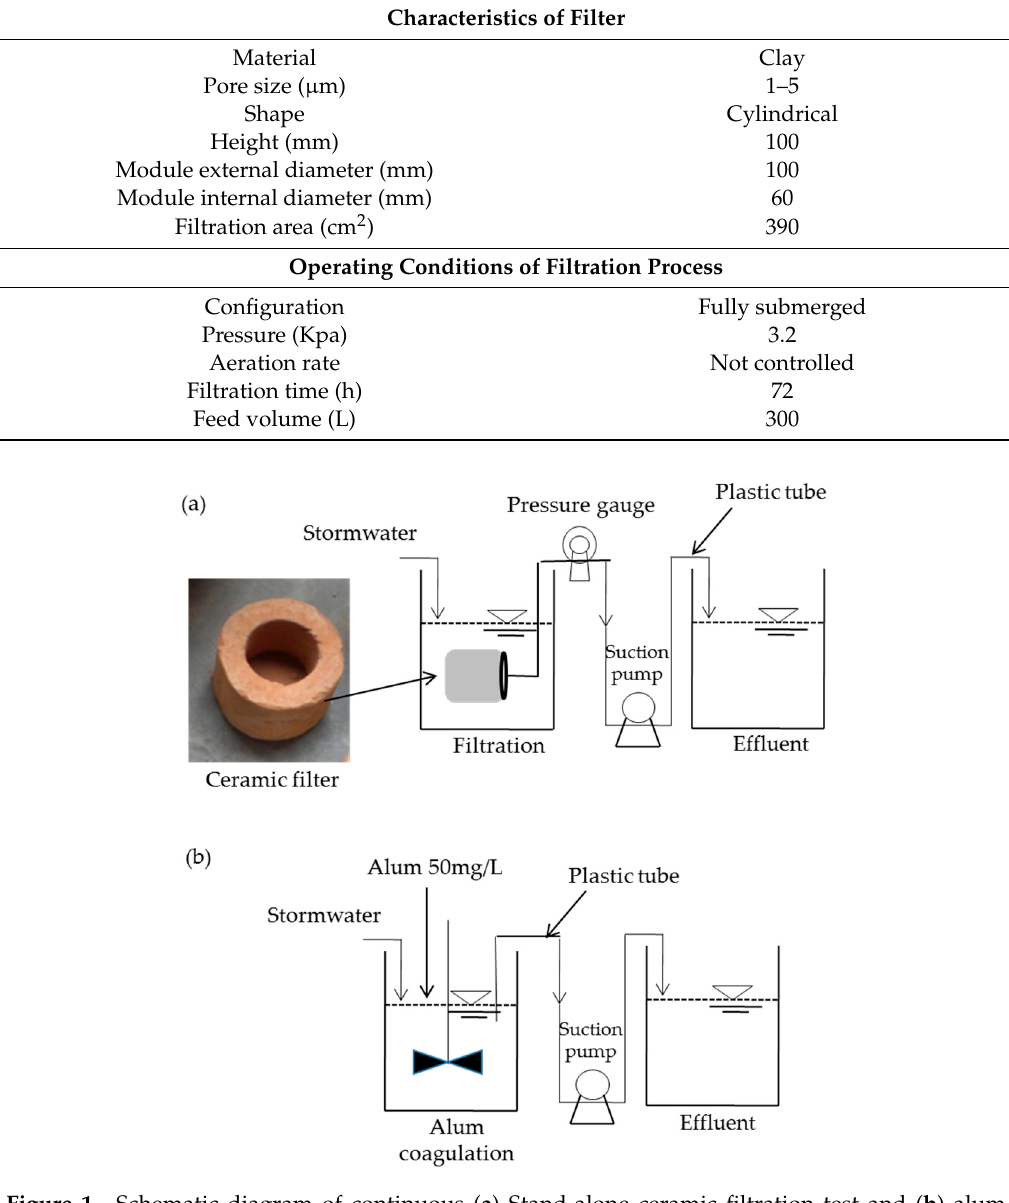
Figure 1. Schematic diagram of continuous ( a ) Stand-alone ceramic filtration test and ( b ) alum coagulation test.